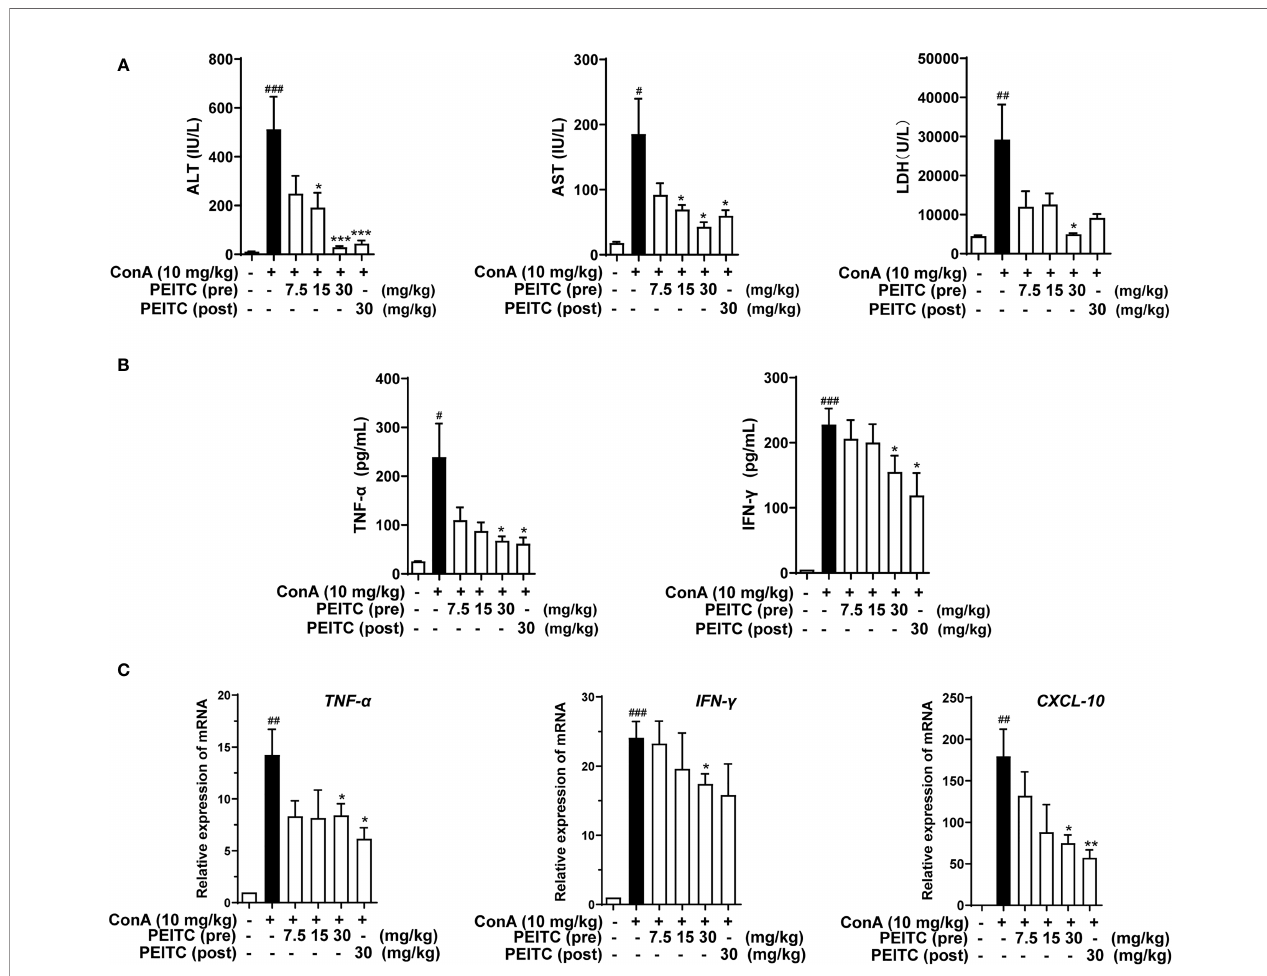
FIGURE 2 | PEITC reduced hepatic biochemical indexes and cytokine levels. (A) The levels of serum ALT, AST, and LDH. (B) Serum TNF- a and IFN- g levels. (C) The mRNA expression levels of TNF- a , IFN- g , and CXCL-10 in liver tissues. Data are presented as means ± SEM ( n = 10 per group). # p < 0.05, ## p < 0.01, ### p < 0.001 vs. normal group, * p < 0.05, ** p < 0.01, *** p < 0.001 vs. ConA